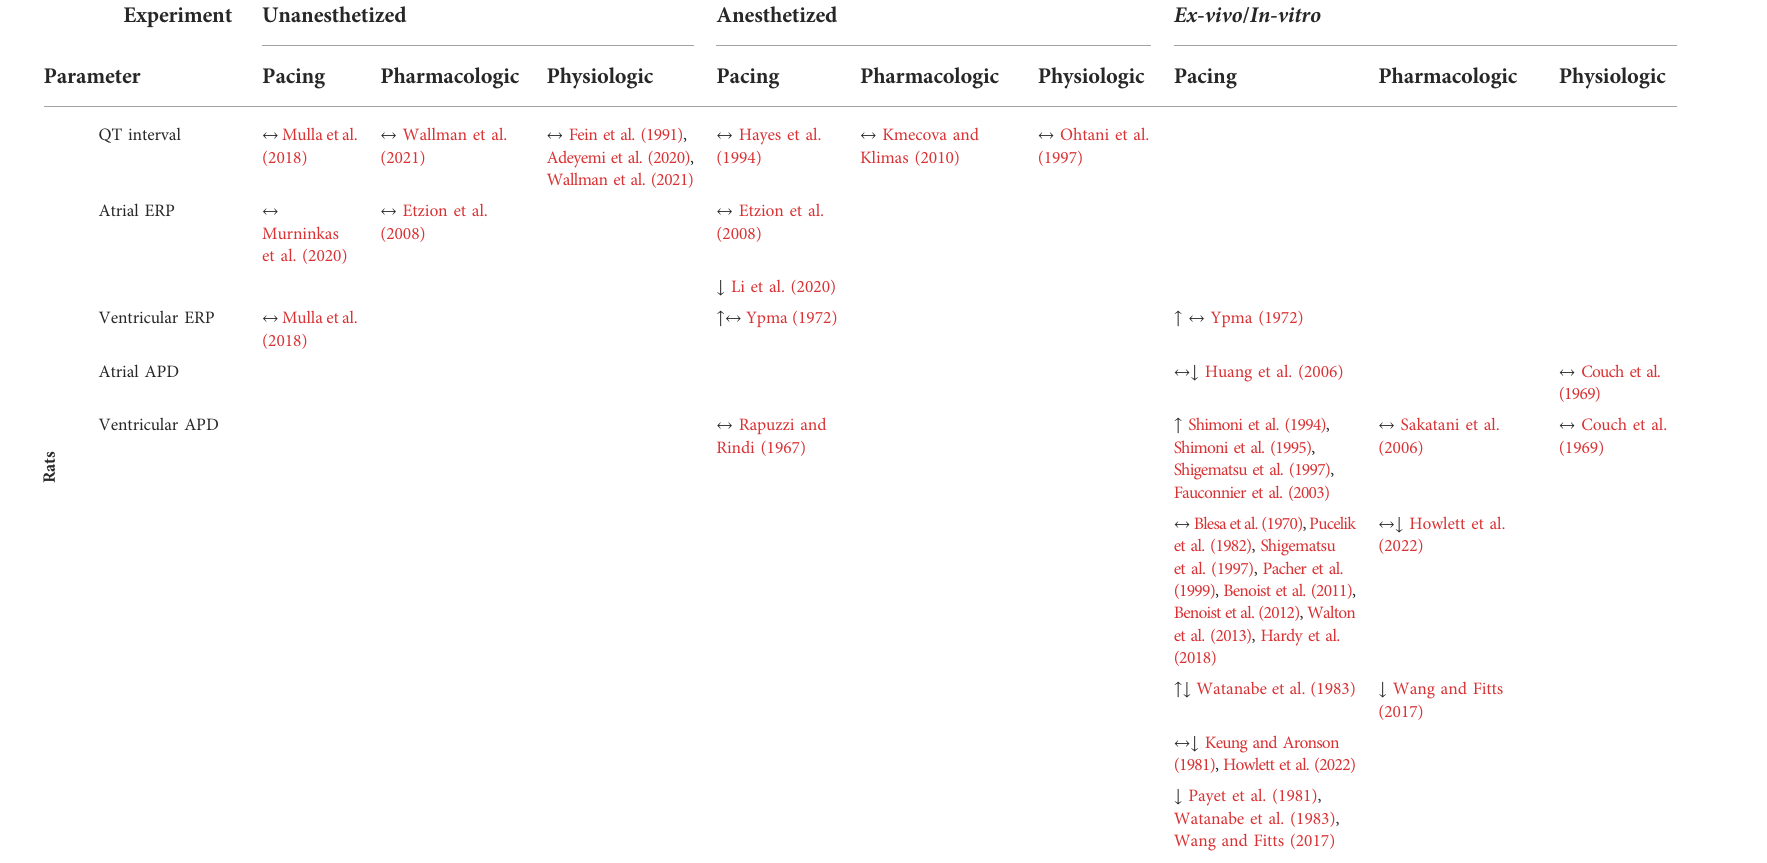
TABLE 1 Summary of studies in which QT interval, ERP and APD rate relation were evaluated in rats and